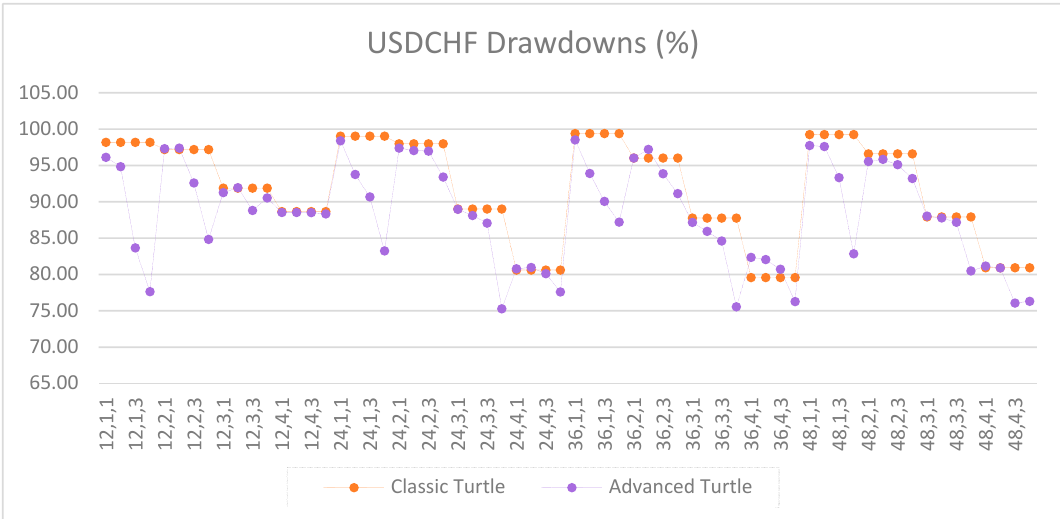
Figure A7. Net profits of USDCHF between the classic and the advanced Turtle systems for every combination of N, X, Y for the fast parameters (20, 40).